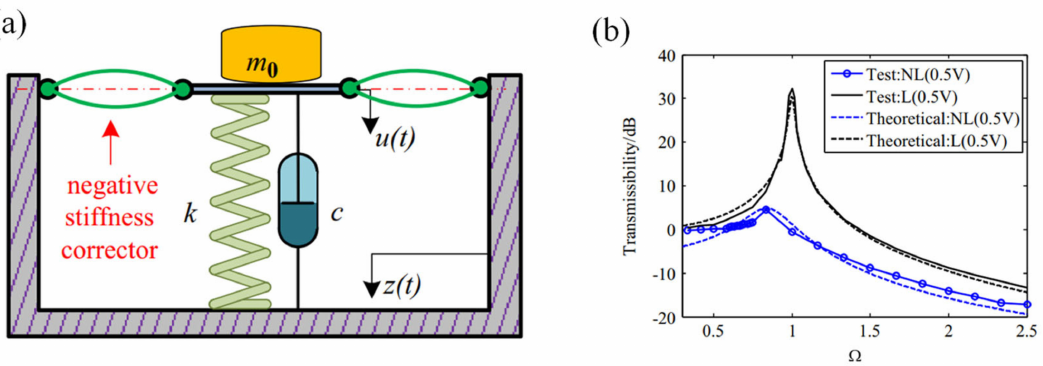
Figure 13. Ultra-low frequency isolator using Euler buckled beams with hinged-hinged boundary working as negative stiffness corrector: ( a ) Model diagram; ( b ) Nondimensional force-displacement of the zero-stiffness system. Figure adapted with permission from Ref. [36]. Copyright 2013, copyright Liu, X.